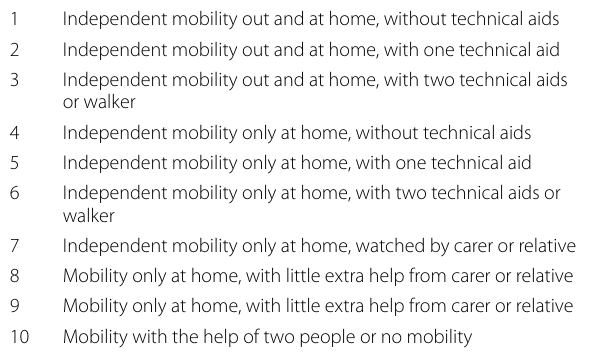
Table 1 Consensus table grading mobility status from 1 to